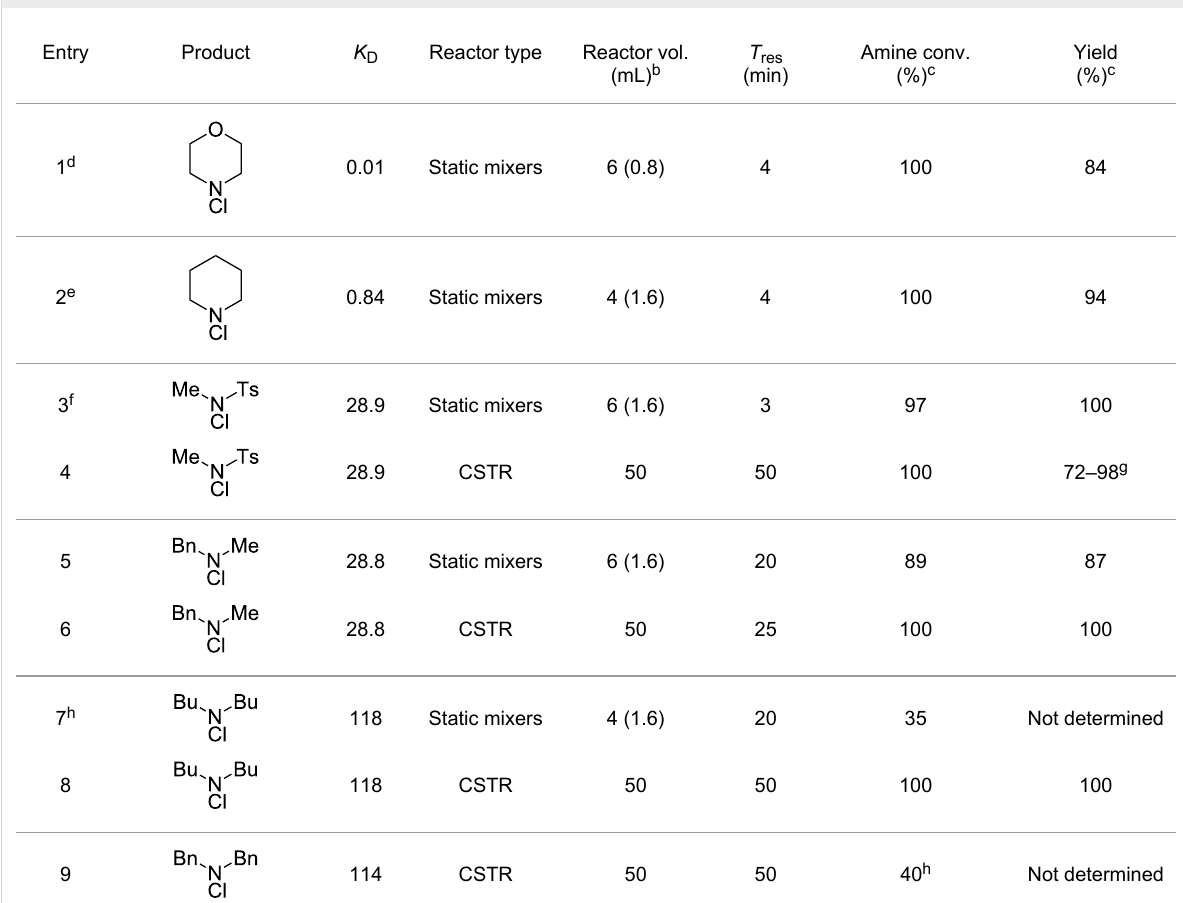
Table 2: Formation of secondary chloramines.